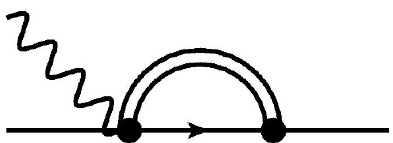
and contains metric (cid:13)uctuations. 3